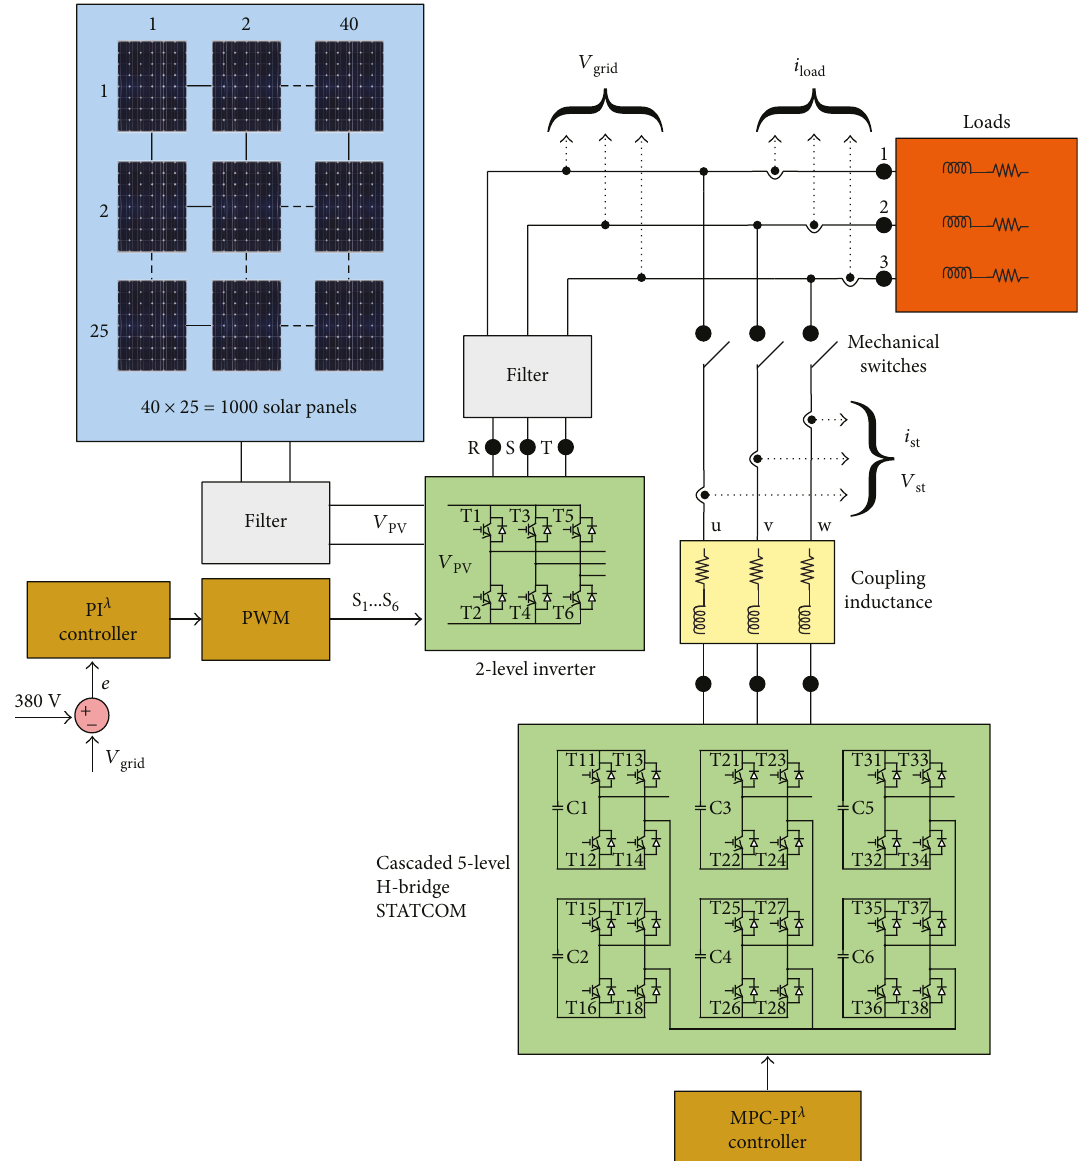
Figure 1: PVSES with a STATCOM